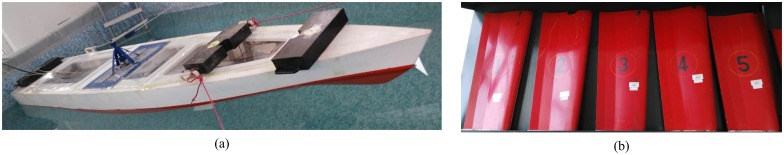
Main experimental equipments in water tank.